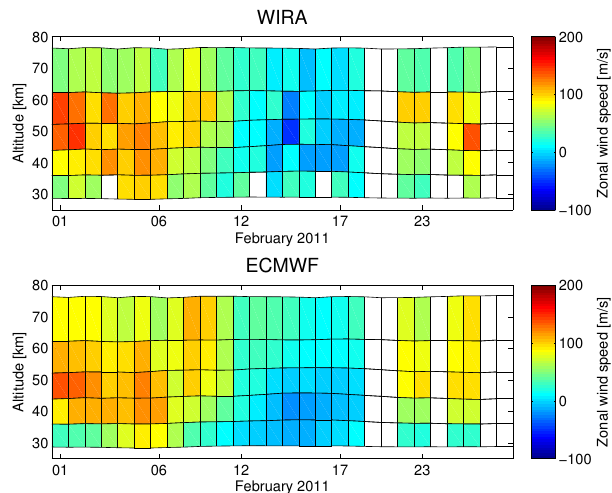
Fig. 12. Daily average zonal wind from WIRA retrieved with the mirror method for February 2011 compared to the data from the ECMWF operational analysis averaged to the WIRA